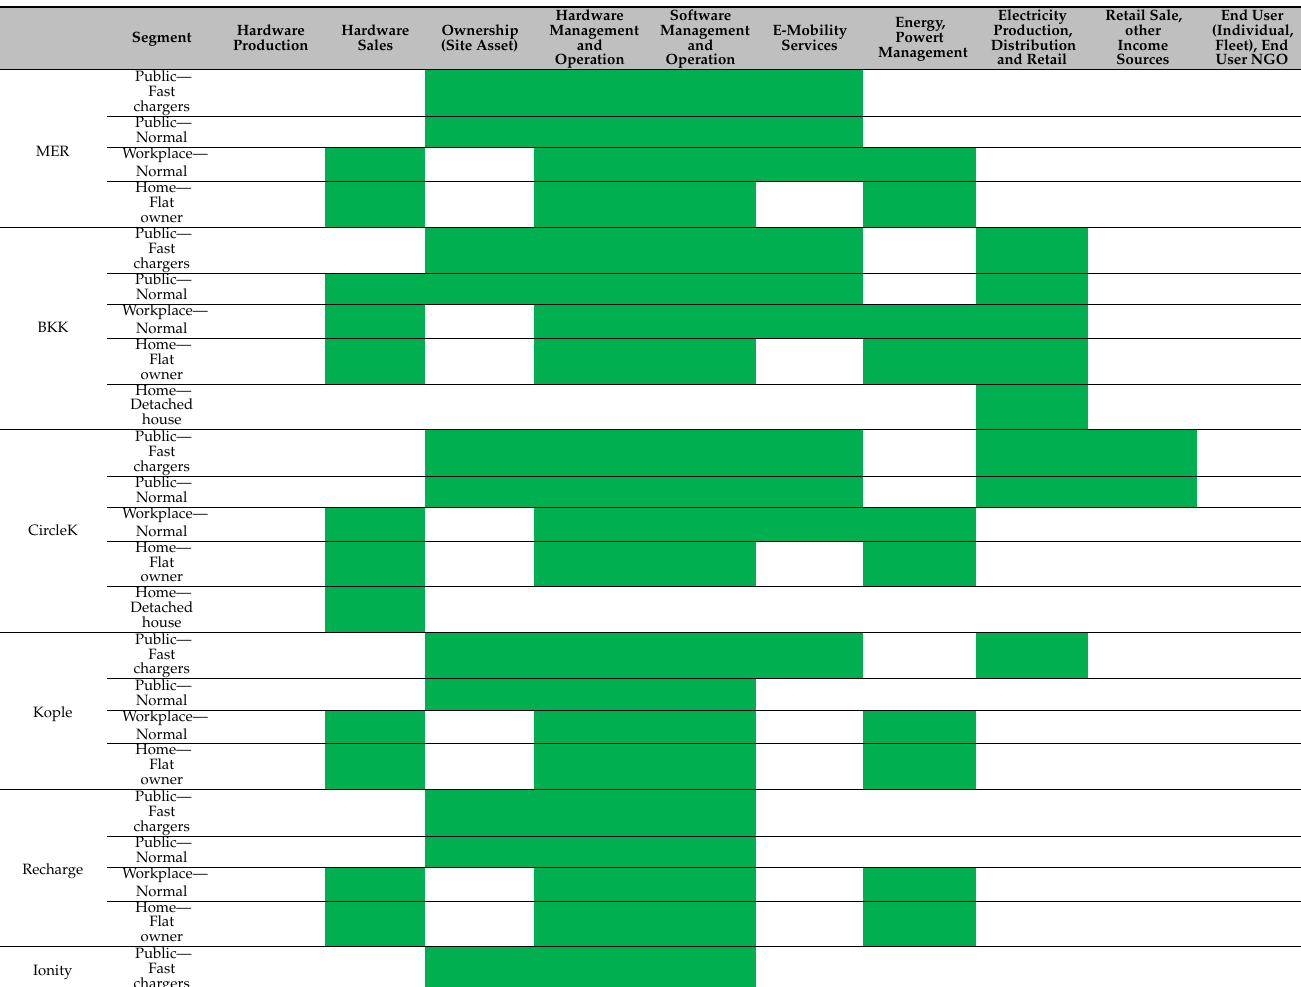
Table 2. Selected actors positioning in the charging infrastructure value chain (see Figure